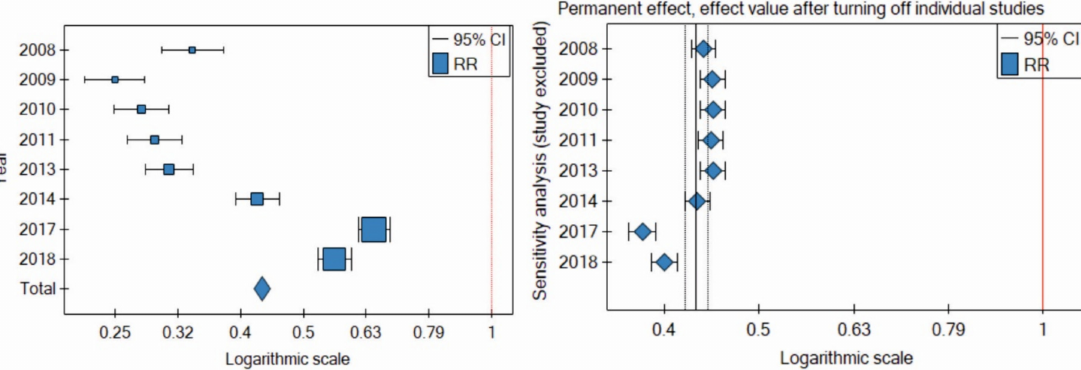
Figure 9. The relative risk of an accident at work among workers aged 65 and over employed in Poland (own